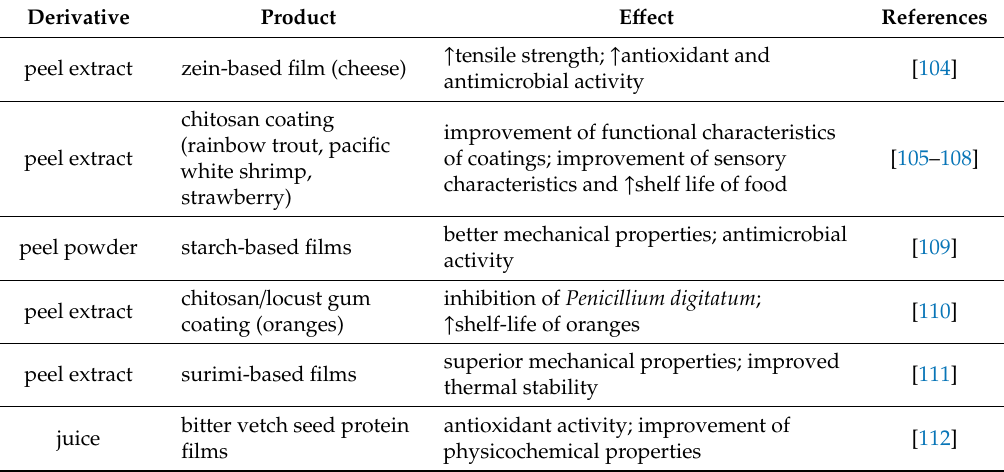
Table 7. Recent studies on the application of pomegranate derivatives to films and coatings.